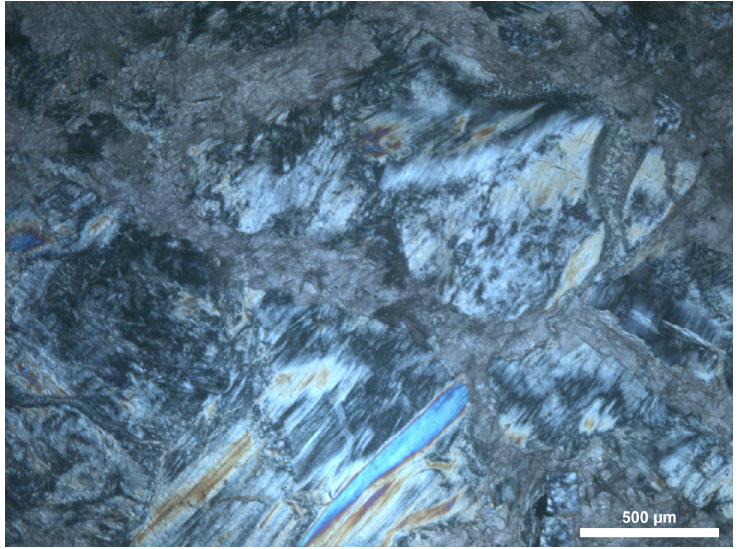
Figure 5. Rock sample after laser ablation.